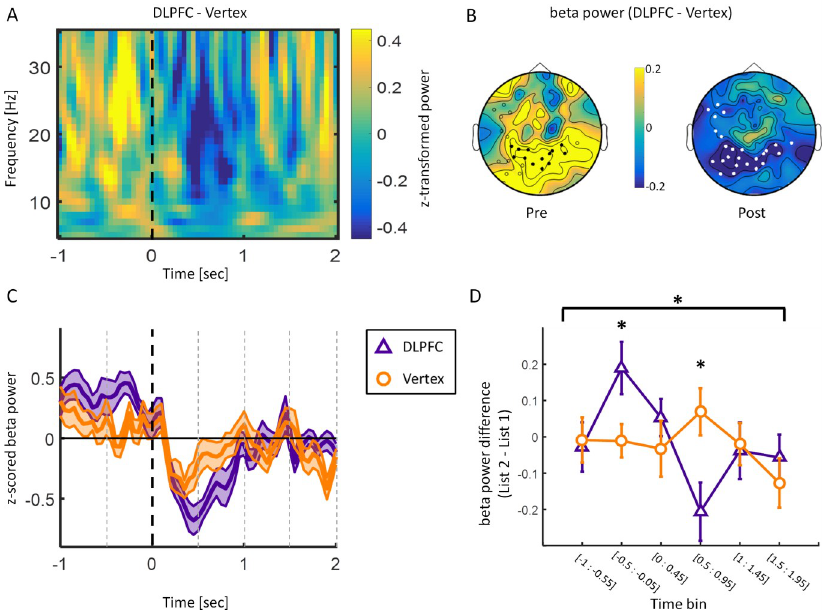
Fig 3. EEG results (only later remembered trials analysed). (A) Time frequency plot for the difference between DLPFC and vertex during List 2 encoding averaged over electrode cluster demonstrating a significant negative difference (i.e., less power for DLPFC compared to vertex) between the DLPFC and vertex group in the beta frequency range poststimulus. Dashed line indicates word onset. (B) Topographies depicting beta power (13 to 30 Hz) difference between DLPFC and vertex stimulation in time windows of interest (pre: − 0.5 s to − 0.05 s; post = 0 to 1 s). White circles depict significant negative electrode cluster poststimulus. Black circles show electrodes within the negative cluster showing a positive difference prestimulus. (C) Time course of beta power (13 to 30 Hz) averaged over the negative electrode cluster shown in B. Shaded area represents standard error of the mean. Black dashed line indicates word onset. Grey dashed lines depict time bins. (D) Beta power difference (List 2 − List 1) over significant negative electrode cluster split by rTMS. Error bars show standard error of the mean. Data were split into 6 nonoverlapping time bins: [ − 1 s to − 0.55 s]; [ − 0.5 s to − 0.05 s]; [0 s to 0.45 s]; [0.5 s to 0.95 s]; [1 s to 1.45 s]; [1.5 s to 1.95 s]. The data and scripts used to generate this figure can be found at https://osf.io/dyxjv/. DLPFC, dorsolateral prefrontal cortex; EEG, electroencephalography; rTMS, repetitive transcranial magnetic